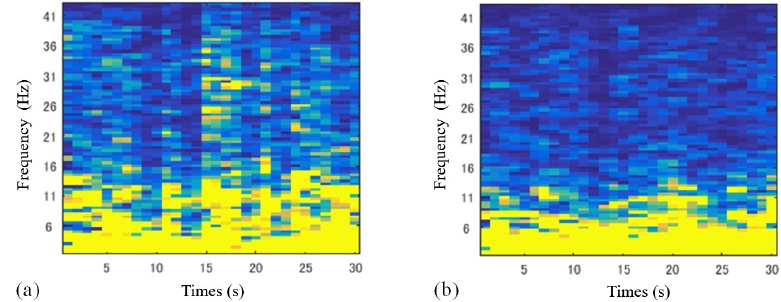
Figure 8. EEG power spectrograms when presenting ( a ) stimulus linked to an individual and ( b ) stimulus not linked to an